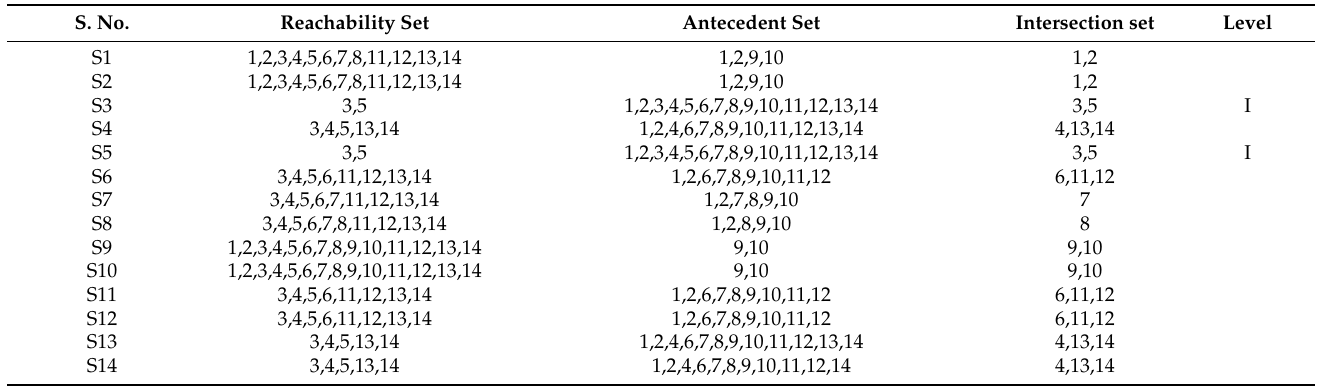
Table A1. Level partitions (Iteration